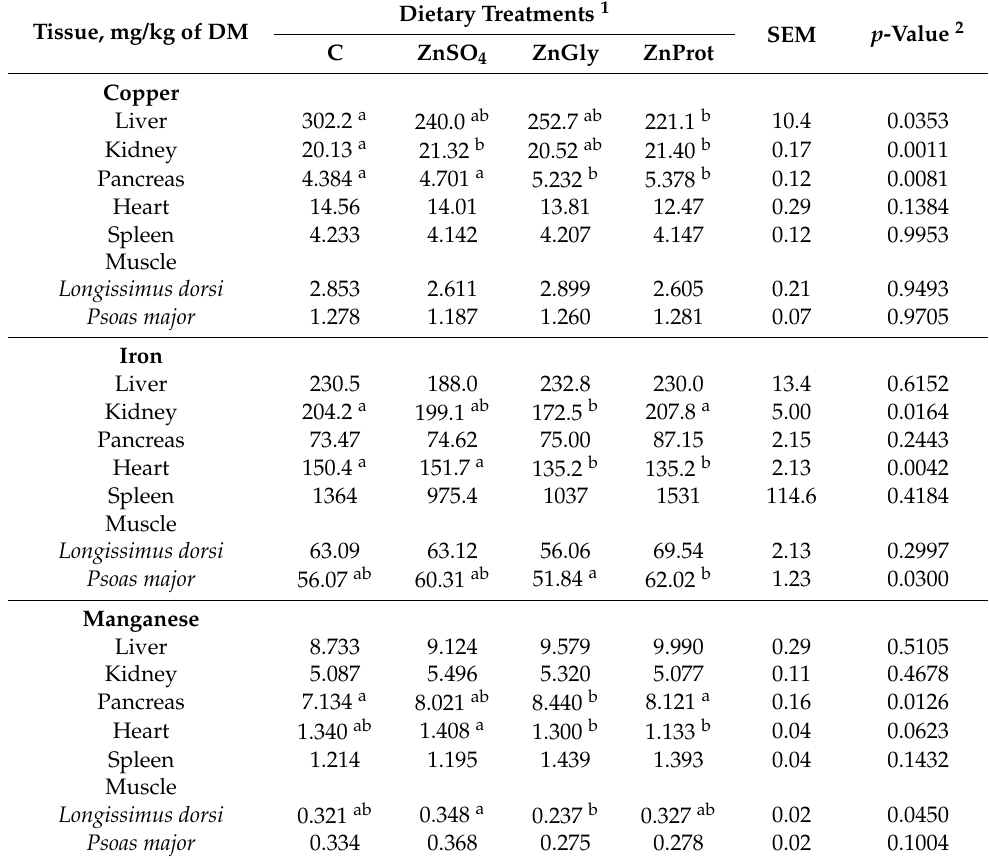
Table 5. Tissue concentrations of Cu, Fe, and Mn in lambs fed diets differing in Zn source (80 mg Mn/kg) for the 120 day feeding